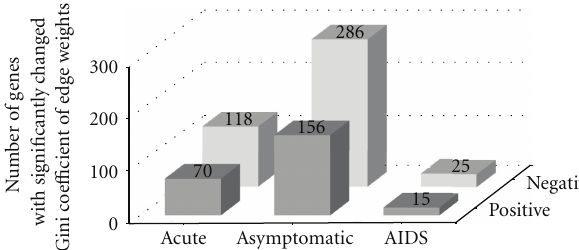
Figure 4: The number of genes with significant Δ G + or Δ G − among GCNs of the uninfected subjects and HIV-1 patients at three di ff erent stages (acute, asymptomatic, and AIDS). “Positive” and “Negative” indicate the Gini coe ffi cients of positive and negative edge weight,